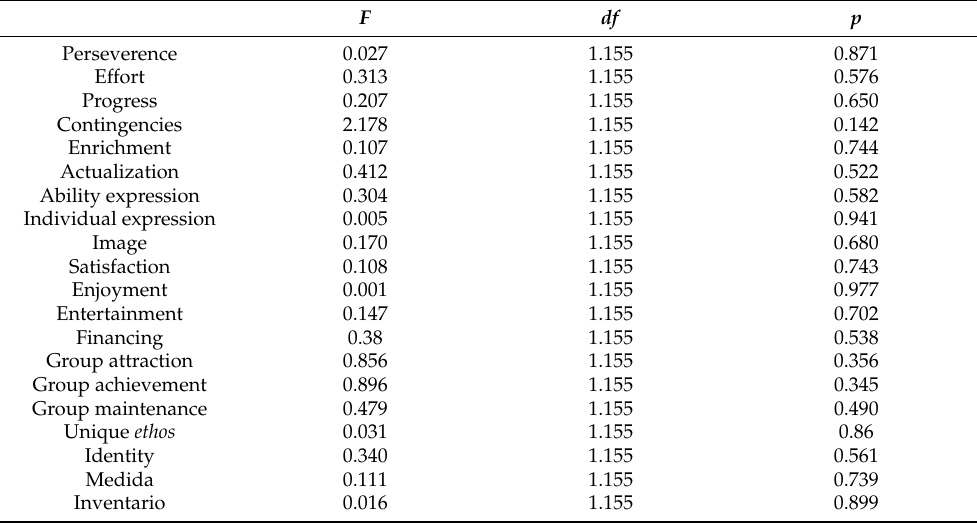
Table 5. Summary of the ANOVA of one factor: Serious Leisure Inventory and Measure (SLIM) considering